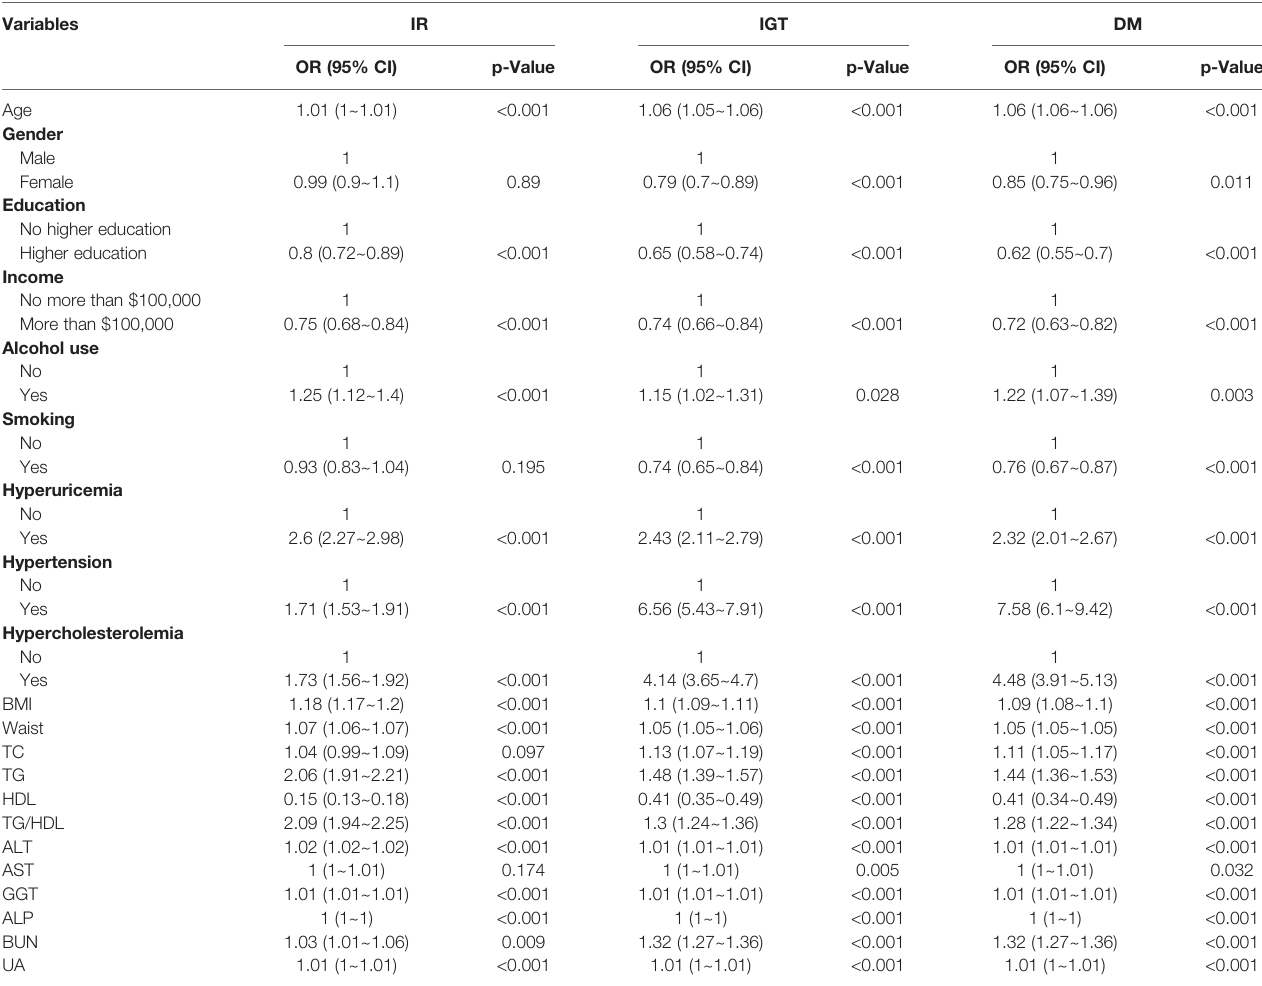
TABLE 2 | Univariate analysis of IR, IGT, and